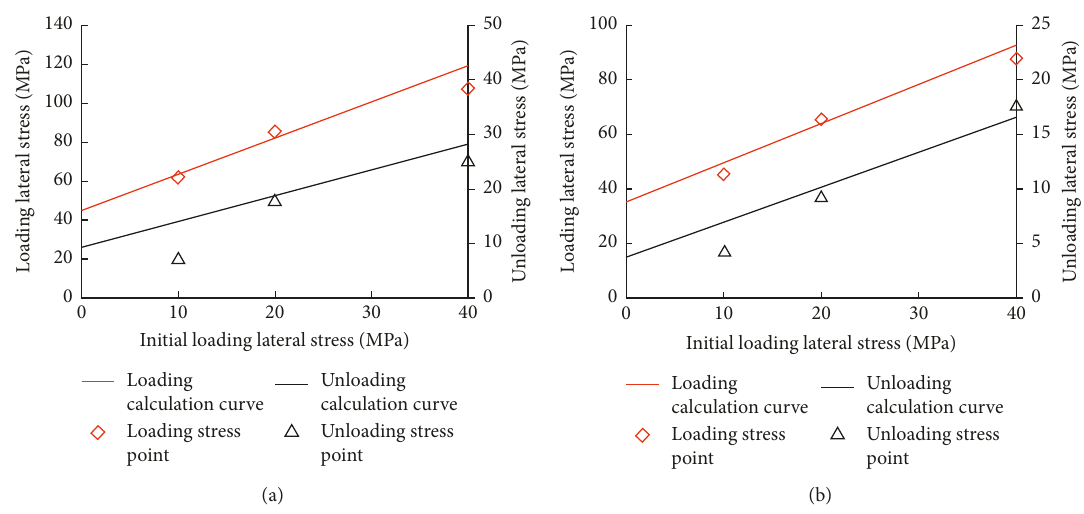
Figure 8: Stress-initial unloading lateral stress plots. (a) Peak stress; (b) Yield